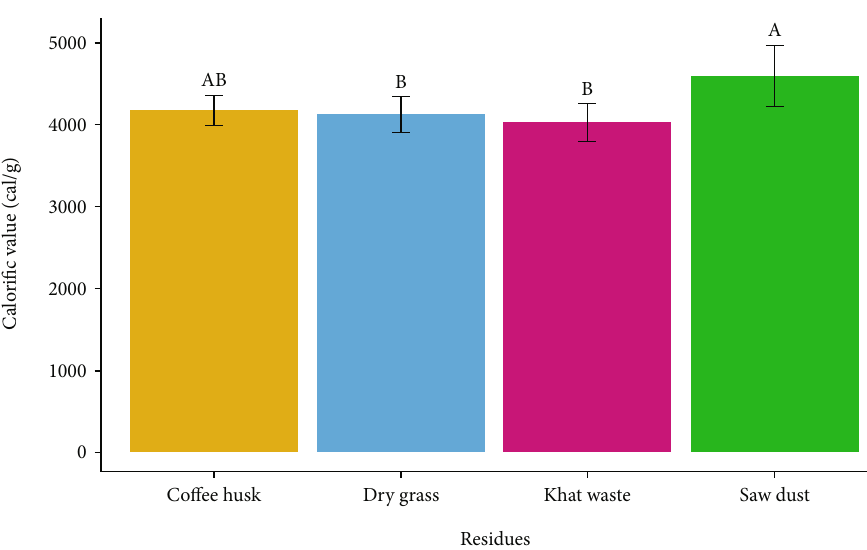
Figure 5: The e ff ect of residues on produced briquettes ’ calori fi c